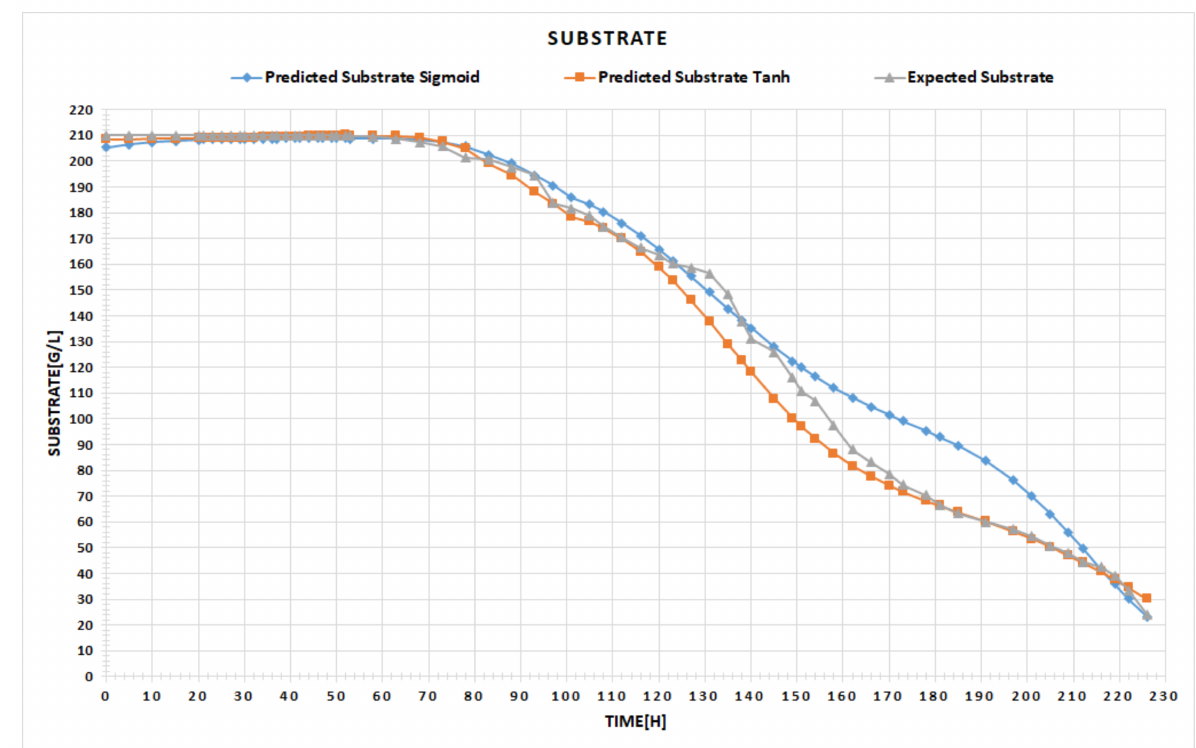
Figure 15. Influence of the activation function on the amount of substrate with a low learning rate